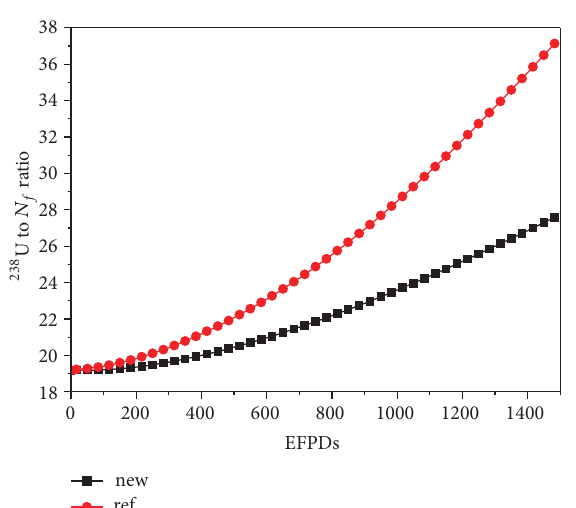
Figure 9: 238 U to 𝑁 𝑓 ratio for 630 ppm boron concentration.